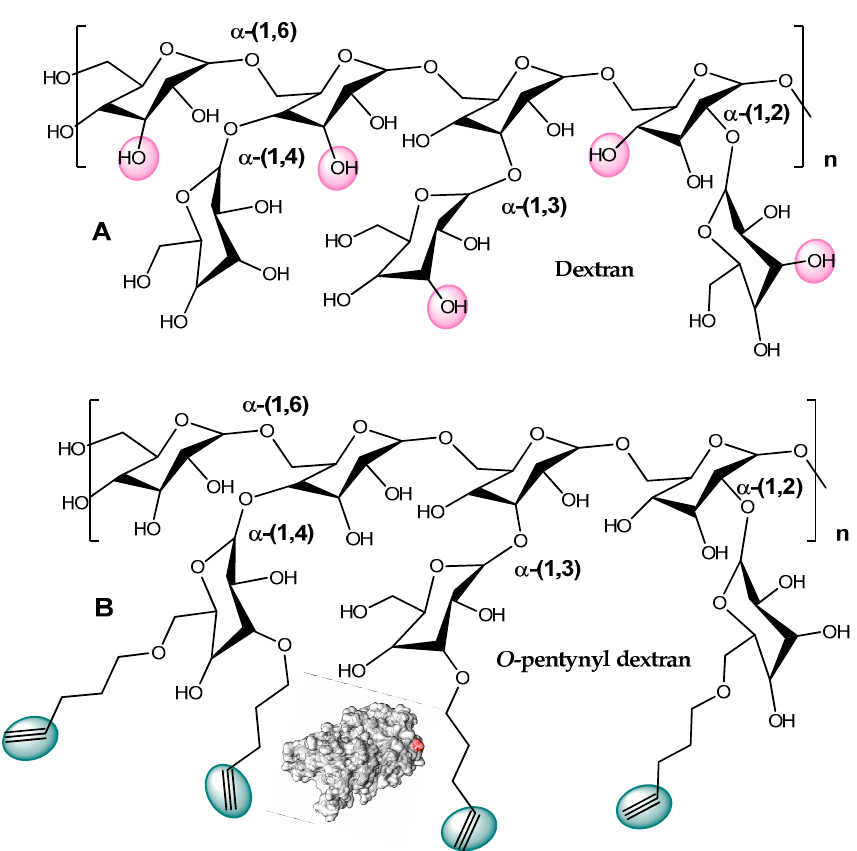
Figure 20. ( A ) Schematic representation of the chemical structure of the dextran ( α - D -glucopyranosyl units). ( B ) Schematic representation of the chemical structure of the O -pentynyl dextran. The light pink circles randomly highlight the hydroxyl groups that can be chemically modified.